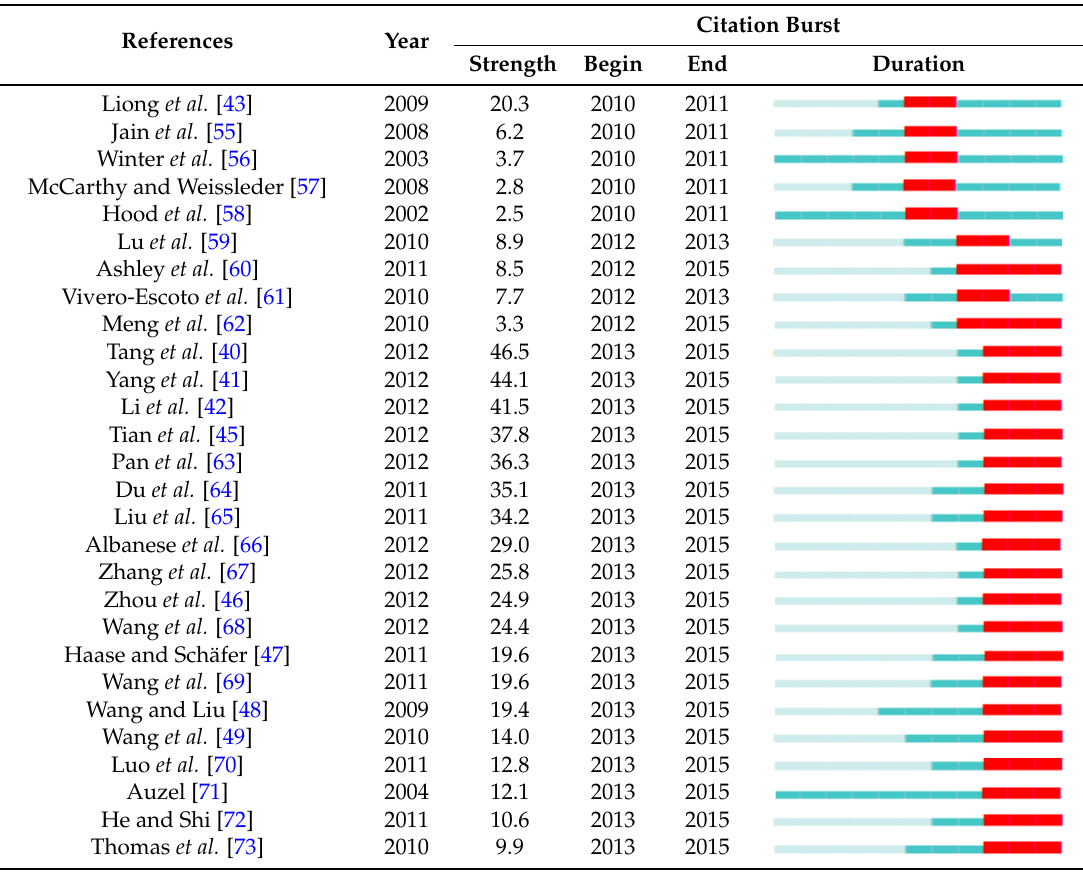
Table 6. References with the most recent citation bursts since 2010.